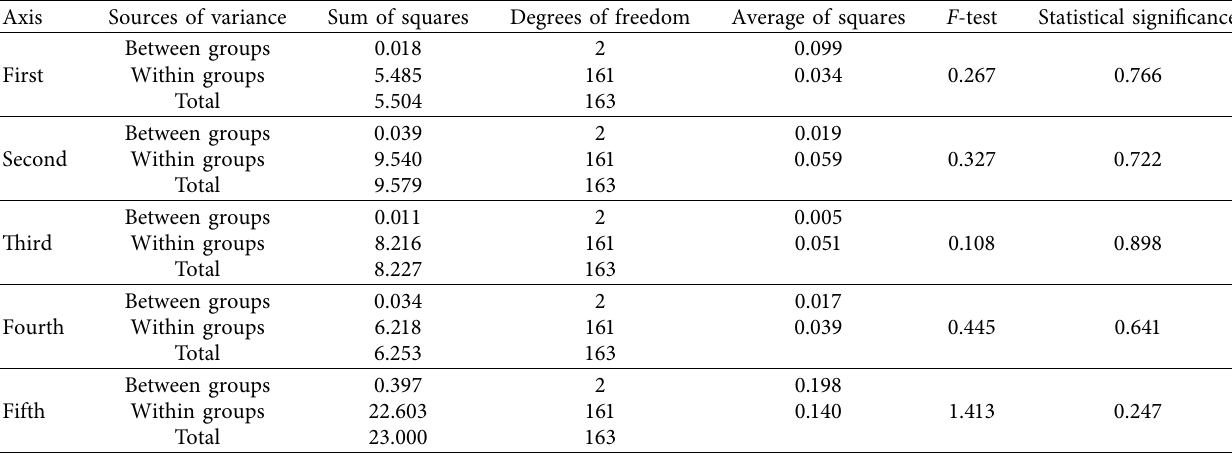
Table 12: Results of the F -test for a comparison of the averages of responses to the questionnaire on the reality of the use of modern teaching methods by the staff at the UOH according to the years of experience variable.